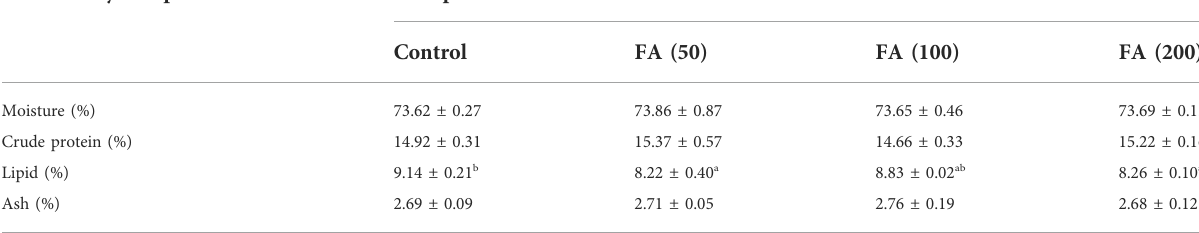
TABLE 4 Whole-body composition of juvenile grass carp fed diets containing graded levels of